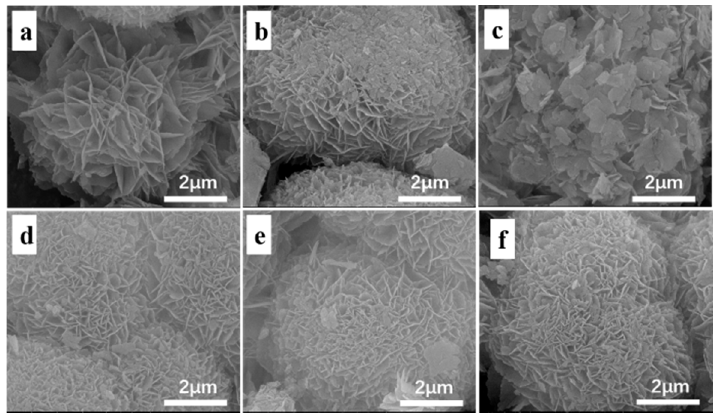
Figure 1. SEM images of H-MCM-22 ( a ) and x Cu / MCM-22 zeolites: ( b ) 2Cu / MCM-22, ( c ) 4Cu / MCM-22, ( d ) 6Cu / MCM-22, ( e ) 8Cu / MCM-22, ( f ) 10Cu / MCM-22.